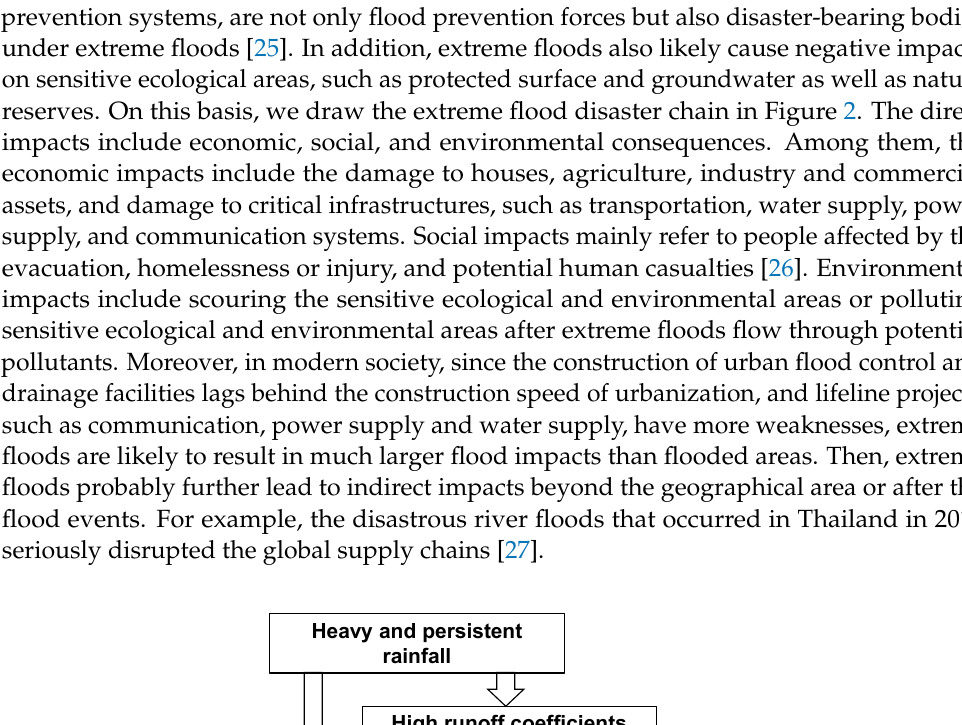
Figure 1. The causative mechanisms of extreme floods.